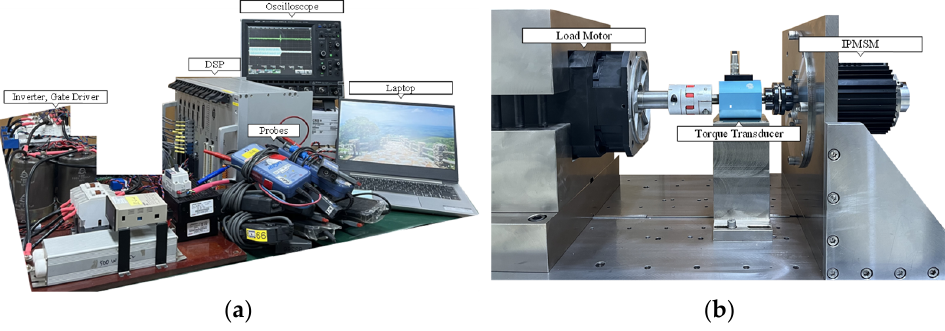
Figure 13. Configuration of the IPMSM test bench. ( a ) The control and measurement part and ( b ) the M-G set with torque transducer.